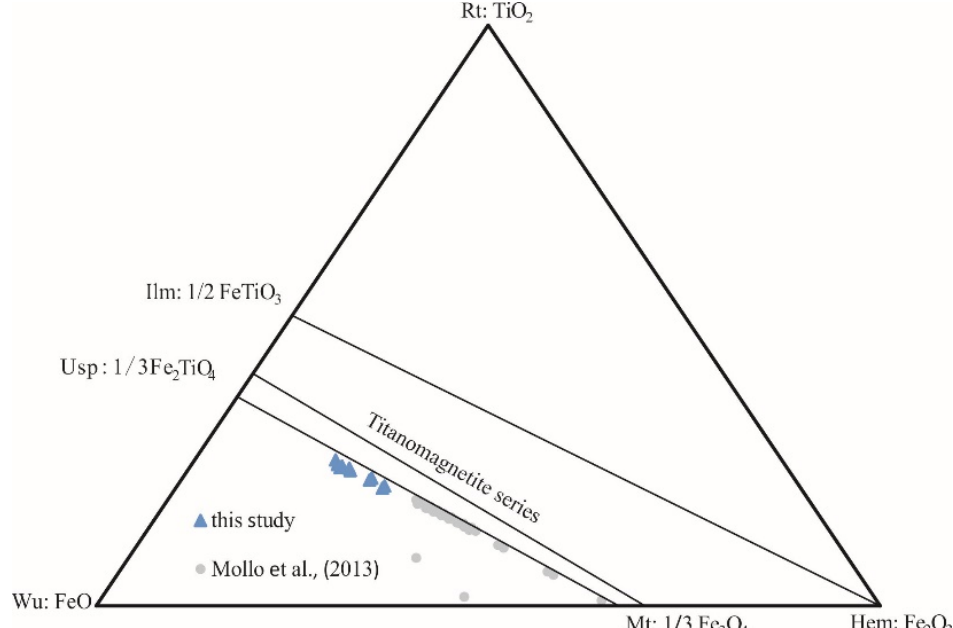
Figure 7. Titanomagnetite compositions from Hannuoba samples are plotted in the FeO–Fe 2 O 3 –TiO ternary diagram. The error bars are within the symbols.